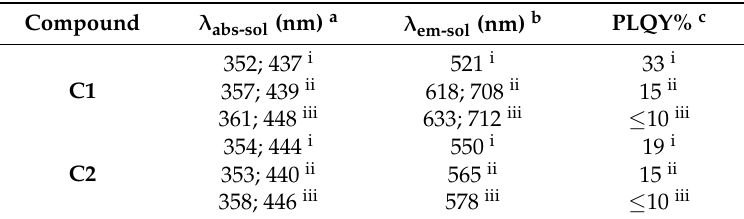
Table 1. Optical data recorded in solution.